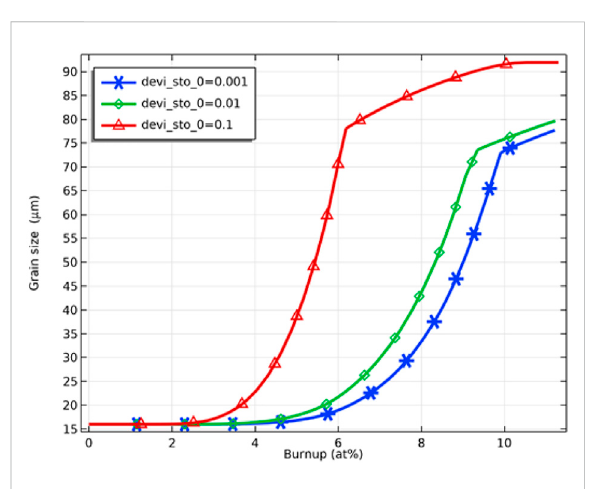
FIGURE 12 Radial variation of grain size at deviation from the stoichiometry of oxygens of 0.001, 0.01, and 0.1 (fuel burnup of 8 at%).